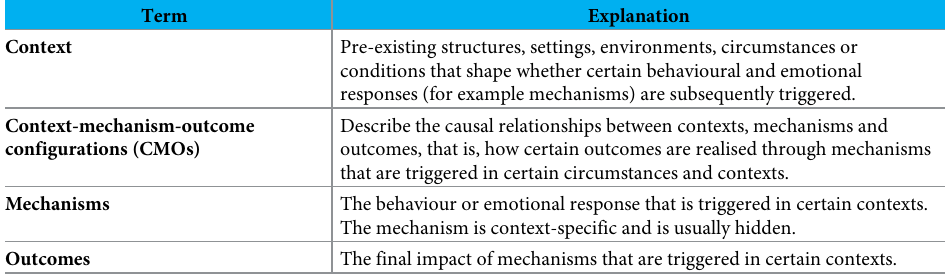
Table 1. Glossary of realist terms used in the